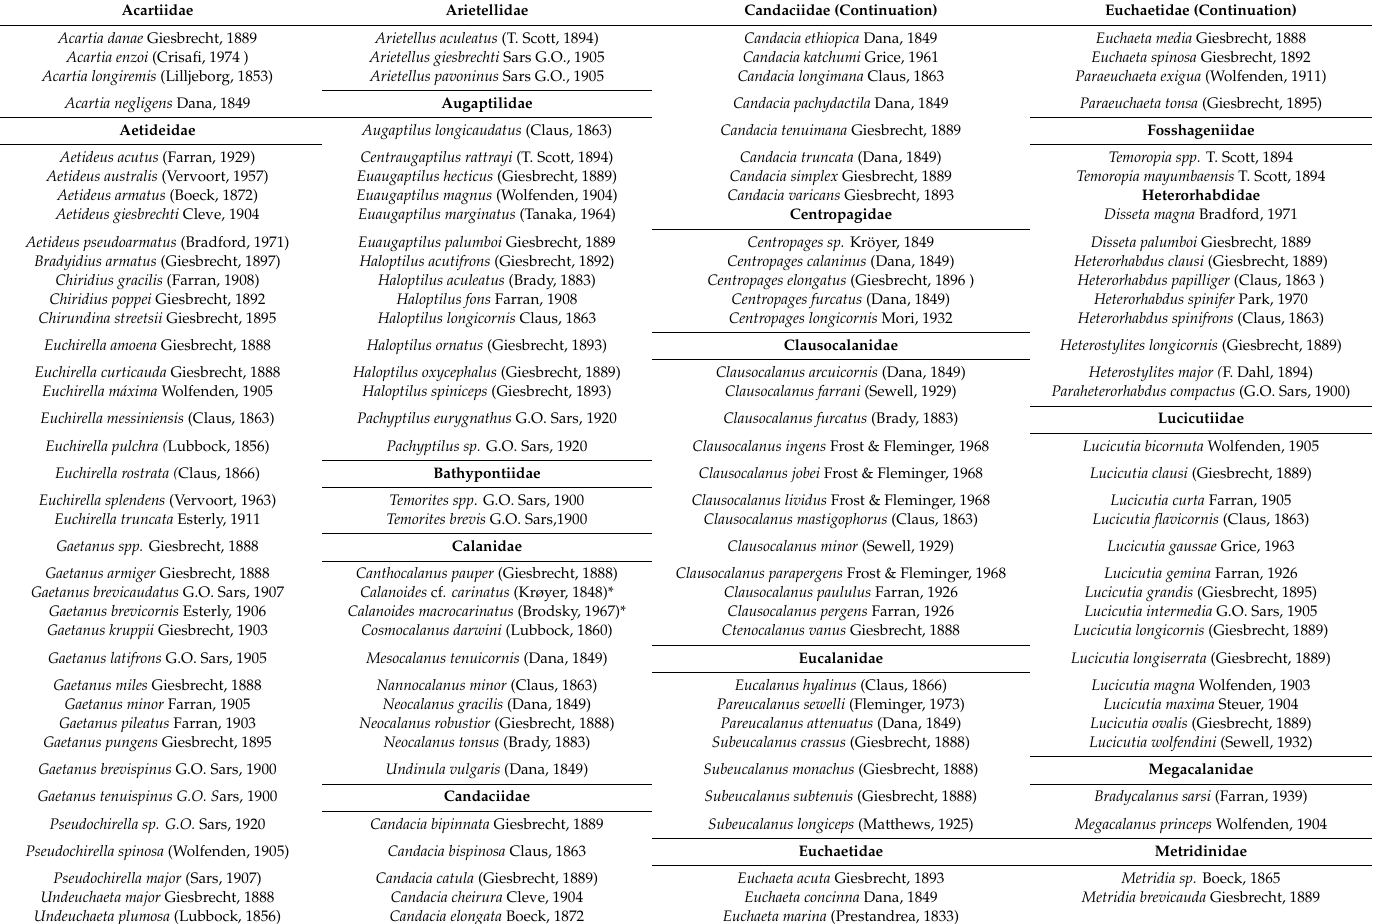
Table 3. List of families and species of copepods identified in this study. No-calanoids families and species are highlighted in grey. *Calanoides from the eastern Atlantic recently re-described